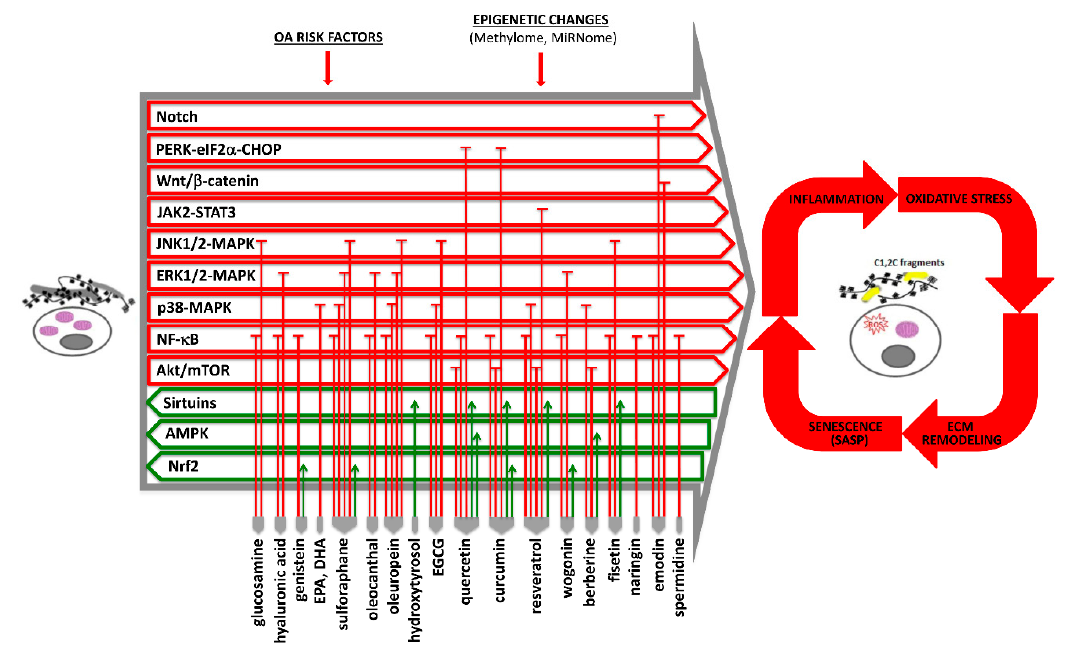
Figure 1. During osteoarthritis (OA) onset and progression, chondrocytes lose their healthy, differentiation-arrested phenotype (represented on the left) and enter hypertrophy and terminal differentiation (represented on the right). This occurs under the effect of different OA risk factors (ageing, mechanical stress, obesity, genetic alteration, and inflammation). Despite the different initial triggers, cartilage with established OA features shows similar patterns of signaling pathways, transcription factors, and epigenetic changes. The final outcome is a tissue in which the cells are exposed to a vicious cycle of inflammatory signals and oxidative stress that boost each other and also sustain extracellular matrix (ECM) remodeling. The increased ECM catabolism further worsens the senescence of articular chondrocytes because they are able to release high levels of senescence-associated secretory phenotype (SASP) molecules that further trigger inflammation. These pathogenetic mechanisms may be targeted by nutraceuticals that are able to both counteract pro-inflammatory and catabolic